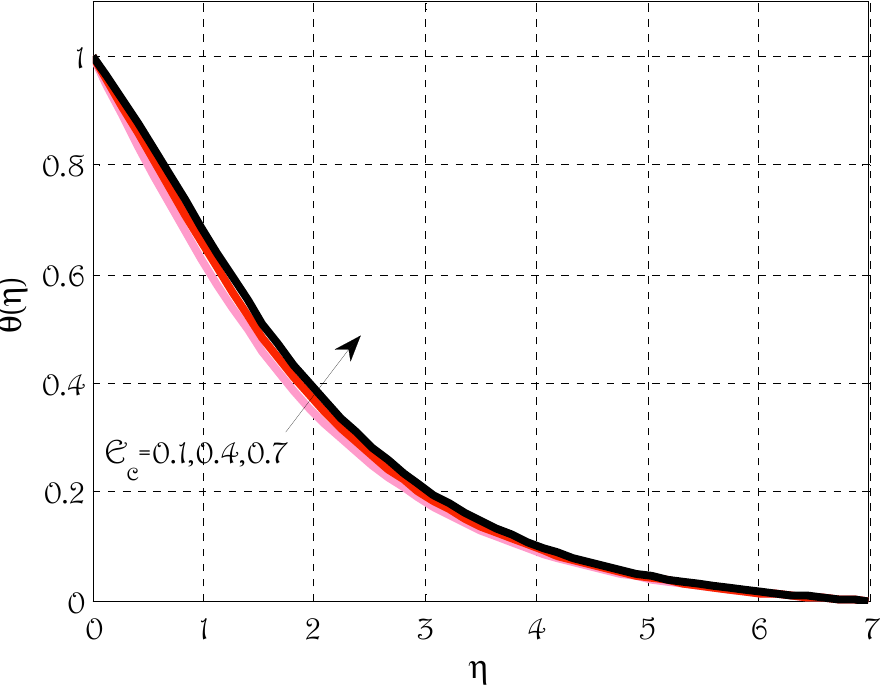
Figure 8. Effect of Eckert number E c on temperature profile θ using k p = 0.5, M = 0.5, R d = 0.7, λ = 0.1, N t = 0.3, N b = 0.1, P r = 1.9, S c = 1.4, γ = 0.1.